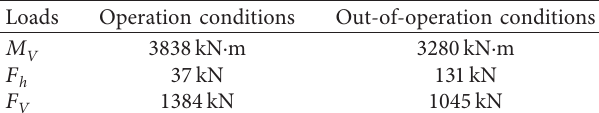
Figure 3: Plane position and lean deviations of steel lattice columns of the tower crane. Table 1: Basic